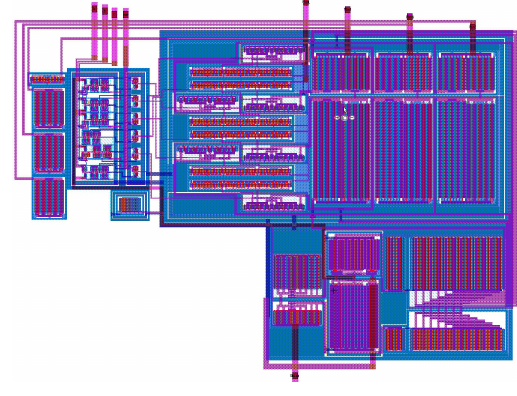
Figure 18. Proposed SNLF Blocks Layout.